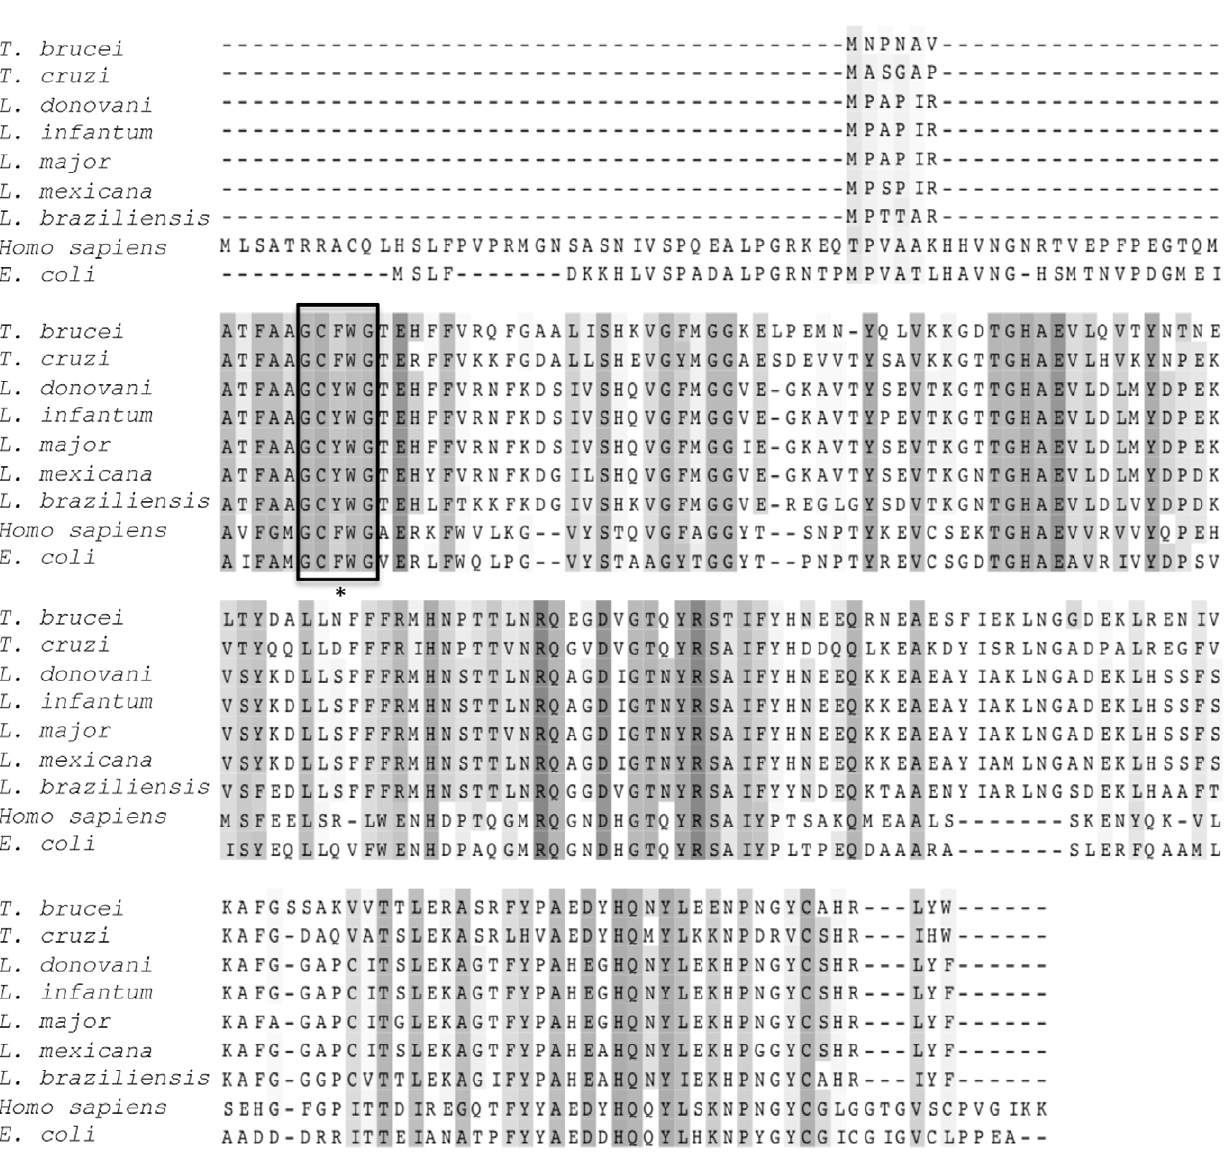
parasites lines. The latter has been shown to reduce free Met-R-O [25,26]. Collectively, these results indicate that LmMsrA is